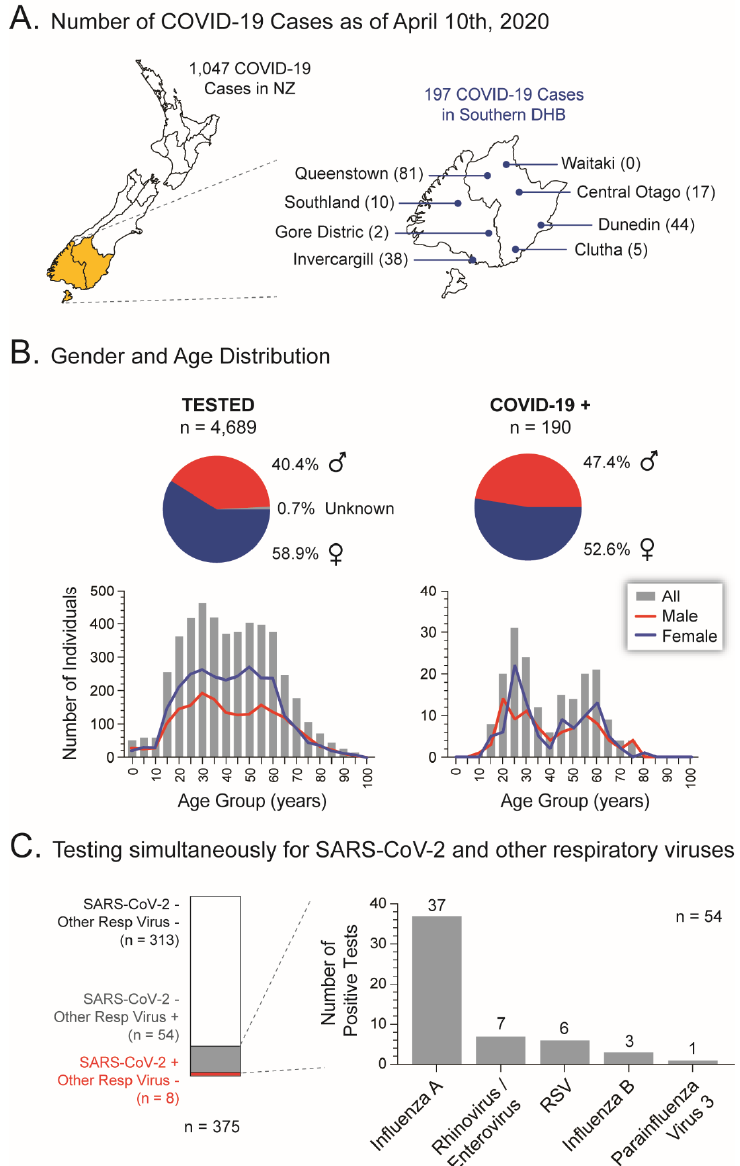
Figure 4. Using the RT-qPCR assay in the Panther Fusion ® System to diagnose COVID-19 in the South Island, New Zealand. ( A ) Total number of COVID-19 cases in New Zealand and the Southern DHB during the first month of the SARS-CoV-2 pandemic in the country. ( B ) Gender and age distribution of the total number of individuals tested, as well as COVID-19 cases, in the Southern DHB during the first four weeks of the SARS-CoV-2 outbreak in New Zealand. ( C ) Identifying multiple respiratory virus infections. Co-infections with other respiratory viruses in individuals positive for SARS-CoV-2 were not detected. RSV, Respiratory Syncytial Virus.